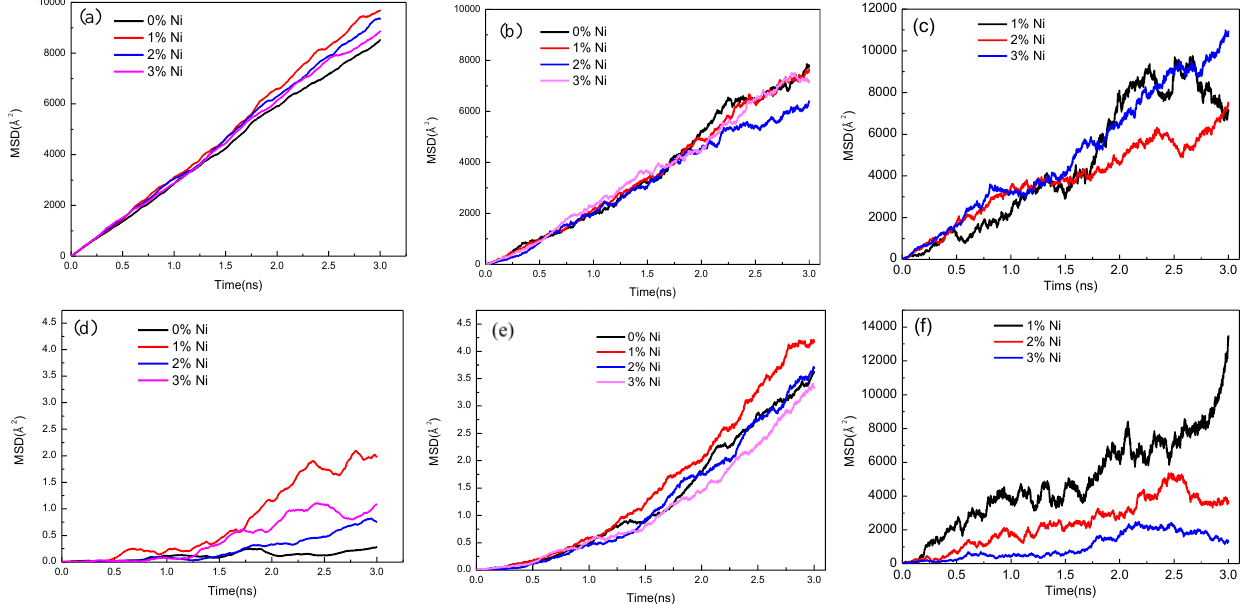
Figure 5. Mean square displacement of Fe, Cu, and Ni atoms away from the interface at 1523 K; ( a ) for all Cu atoms with different nickel contents, ( b ) for Cu atoms in the Fe matrix with different concentrations of nickel atoms, ( c ) for Ni atoms in the Cu 1 − x Ni x matrix with different nickel contents, ( d ) for all Fe atoms with different nickel contents, ( e ) for Fe atoms in the Cu 1 − x Ni x matrix with different concentrations of nickel atoms, and ( f ) for Ni atoms in the Fe matrix with different nickel contents.